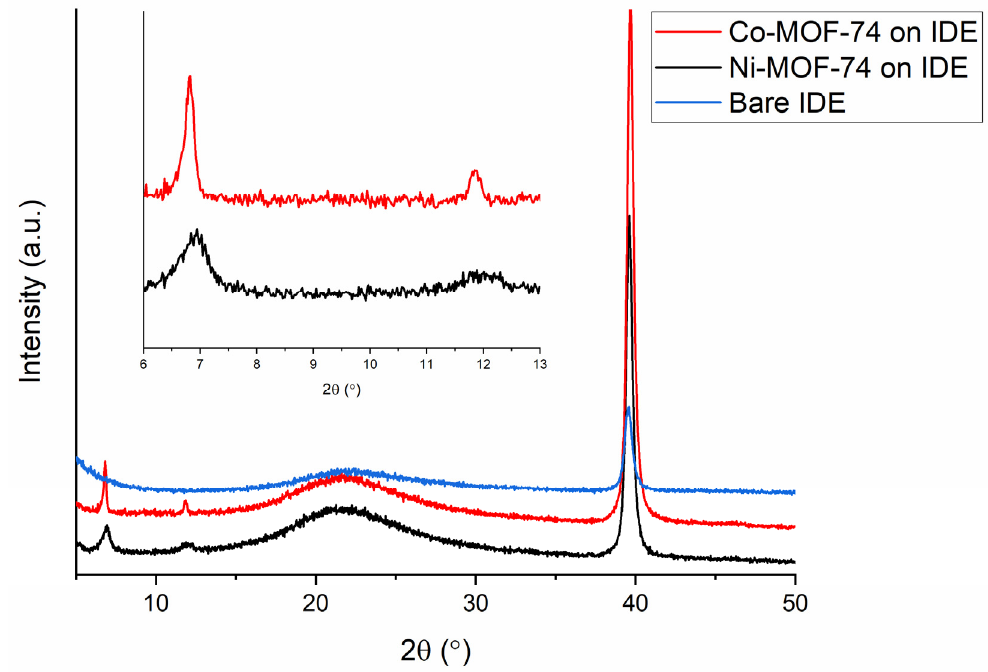
Figure 3. Powder X-ray diffraction patterns for bare IDE (blue), Co-MOF-74 (red) and Ni-MOF-74 (black) grown on IDEs. Inset from 6 to 13° 2 θ highlights the 2 primary MOF peaks for each MOF. The peak at 40° 2 θ corresponds to Pt, and the broad diffuse hump at 15–30° 2 θ corresponds to glass.